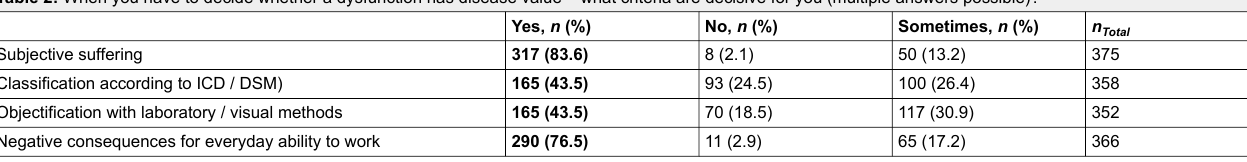
Table 2: When you have to decide whether a dysfunction has disease value – what criteria are decisive for you (multiple answers possible)? Yes, n